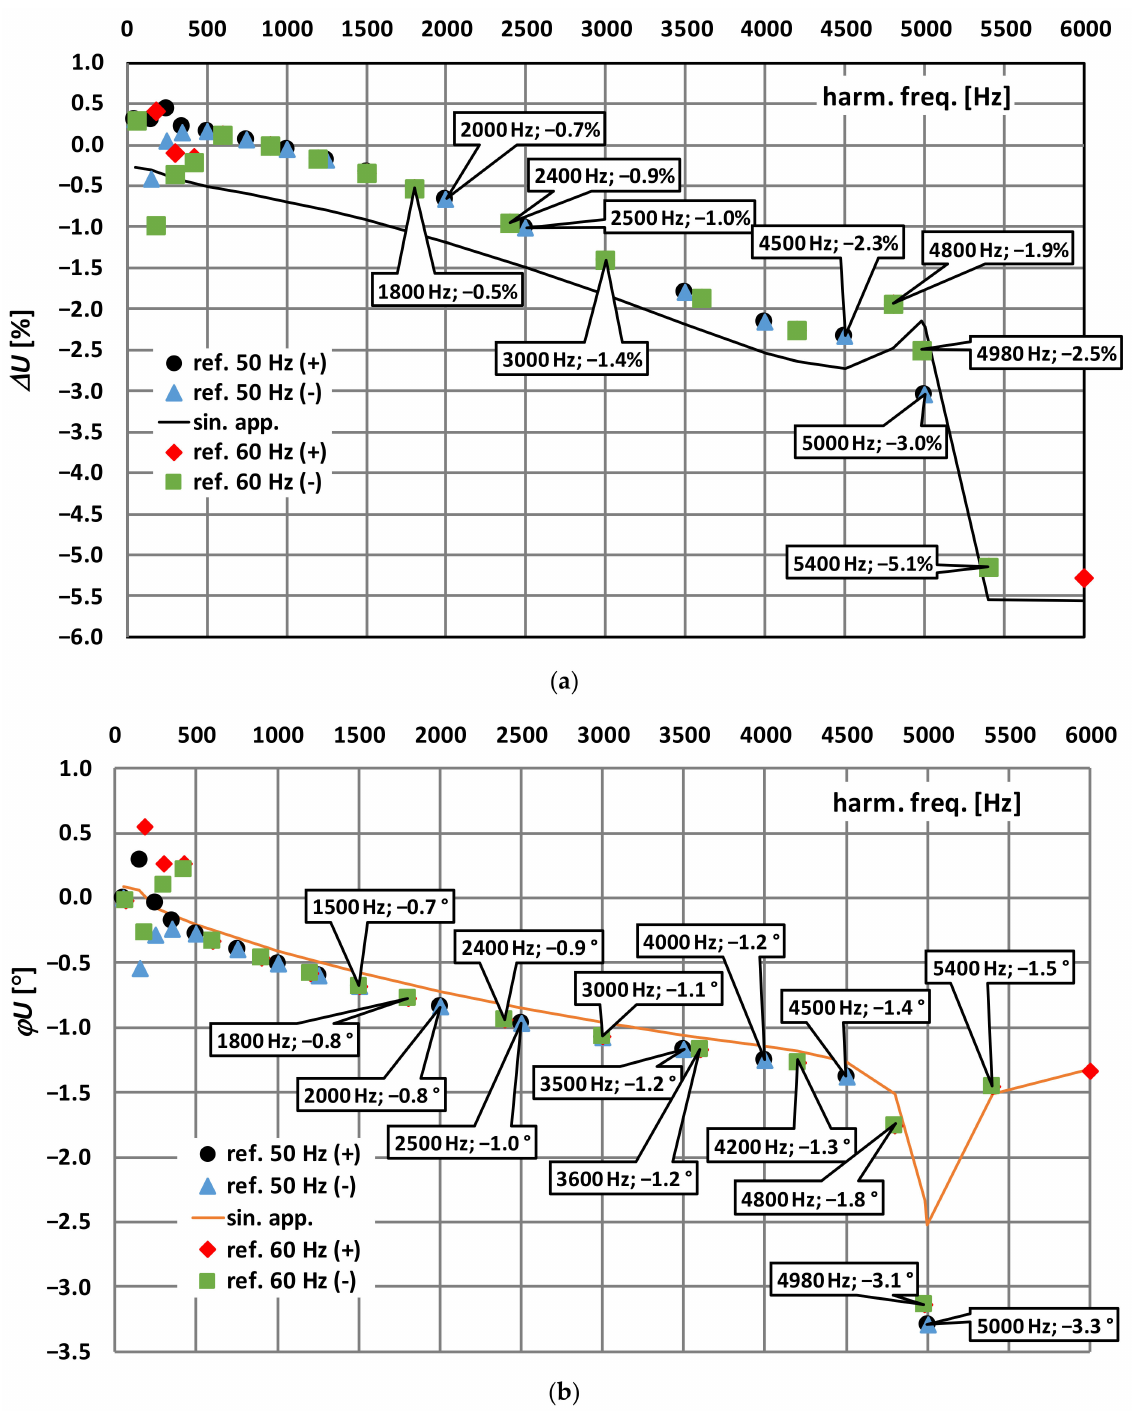
√ 3) kV VT for harmonics of the non-sinusoidal and